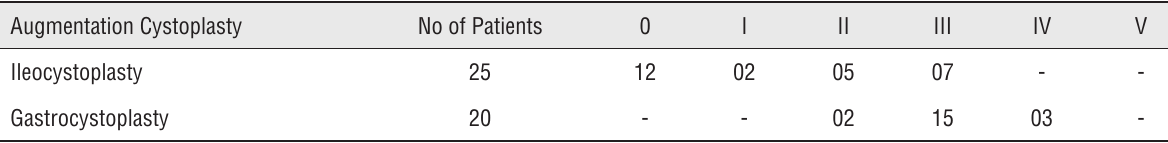
Table 3 - Baseline CKD stage Distribution In Ileo-cystoplasty And Gastro-cystoplasty. Augmentation Cystoplasty No of